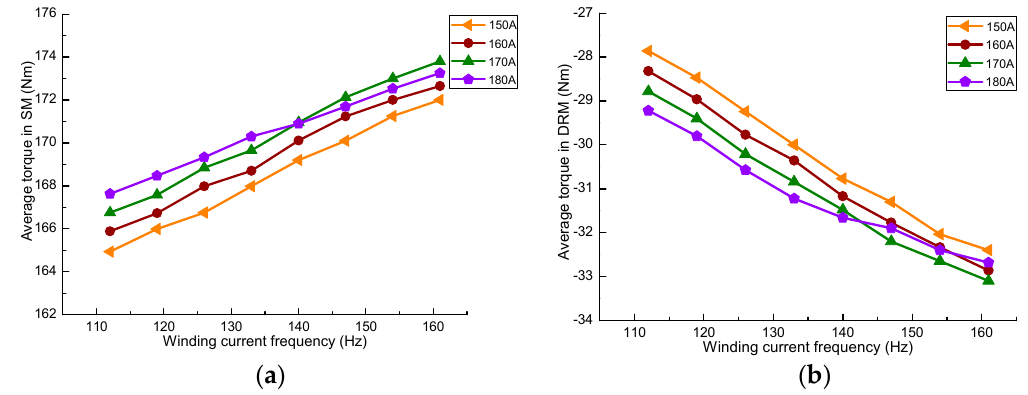
Figure 6. Variation of average torque curve in SM and DRM with winding current frequency: ( a ) SM; ( b ) DRM.